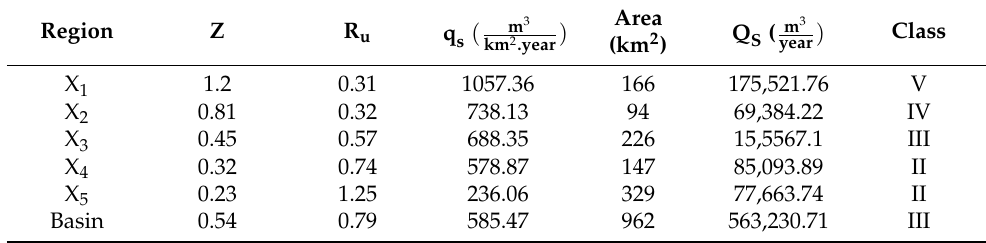
Table 10. Classification of sub-basins using EPM method.